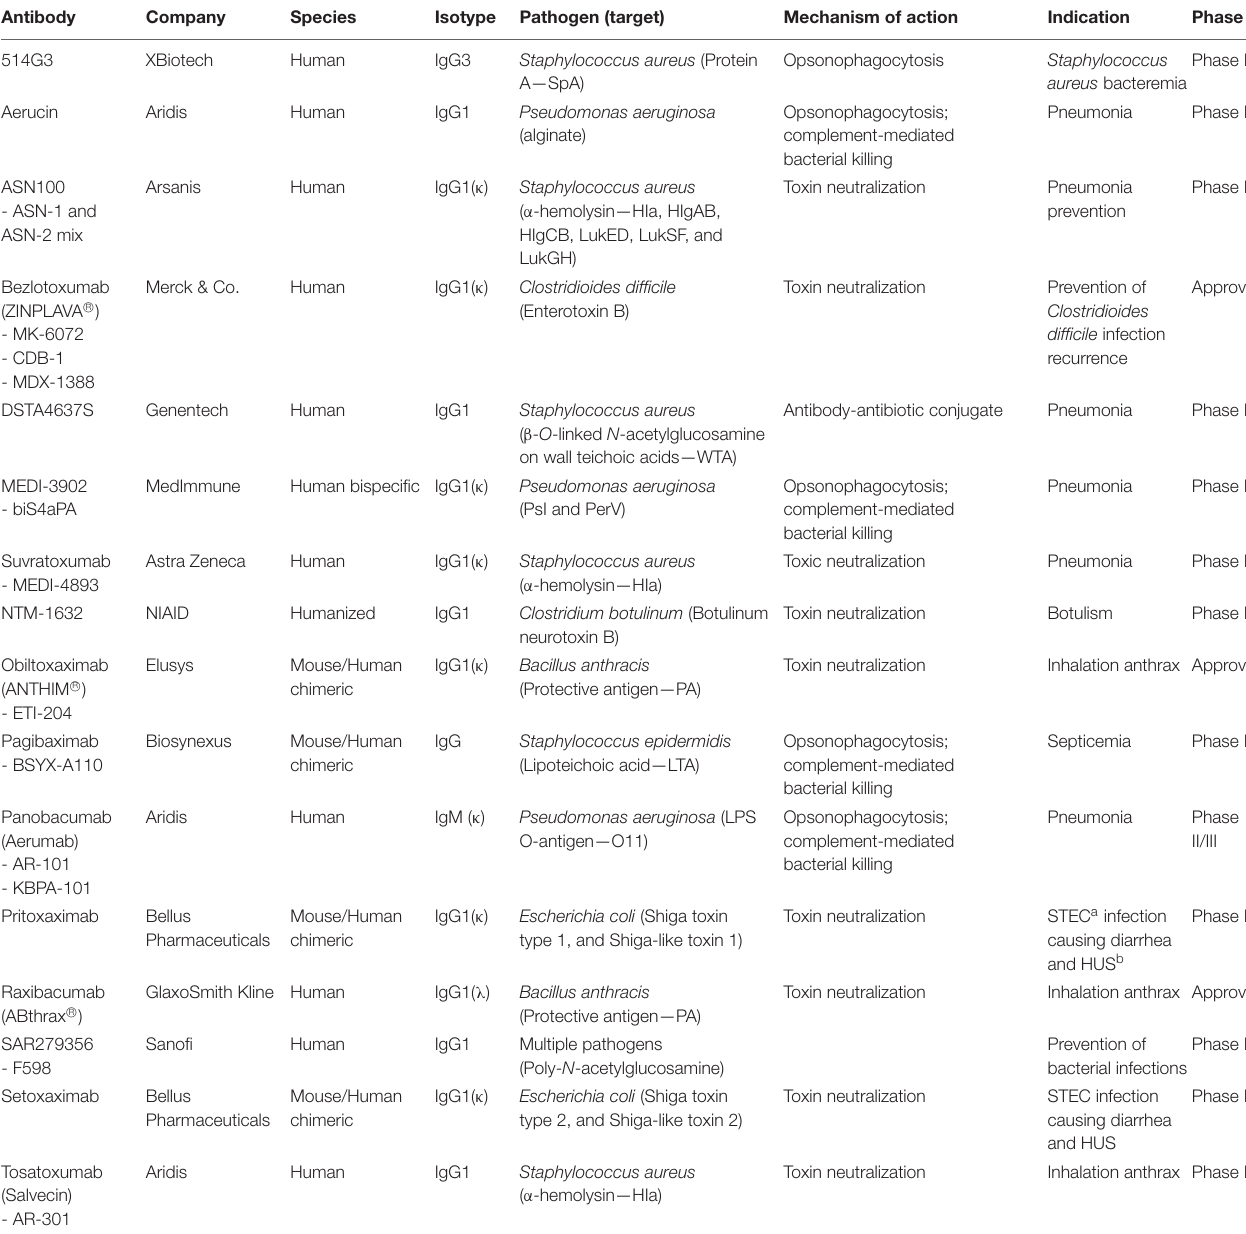
TABLE 2 | Monoclonal antibodies and antibody-based biologics that have been tested in clinical trials for use in bacterial infections.